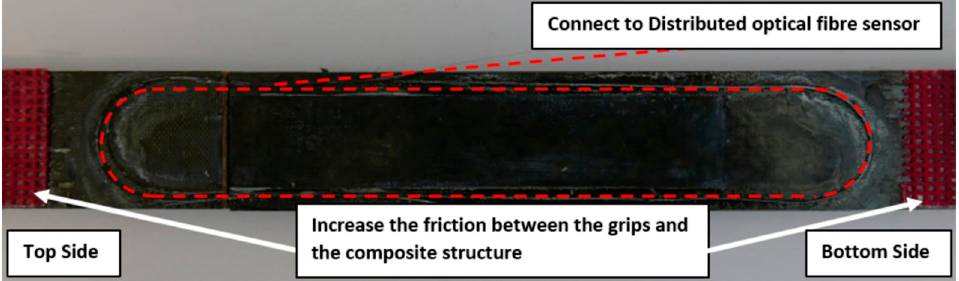
Figure 4. Demonstration of the bonded fibre (dotted line) along the composite specimen.